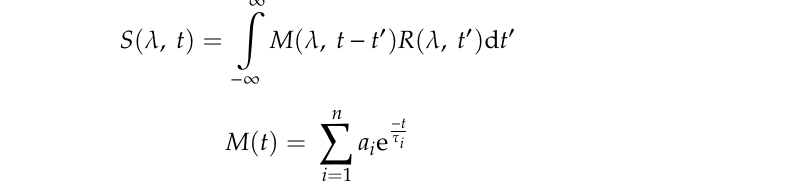
Table 4. Summary of time constants resulting from the global fit of the TAS of molecules 9–12 in methanol studied by Losantos et al. [84] . Reproduced and adapted from [84] , with permission from the PCCP Owner Societies.